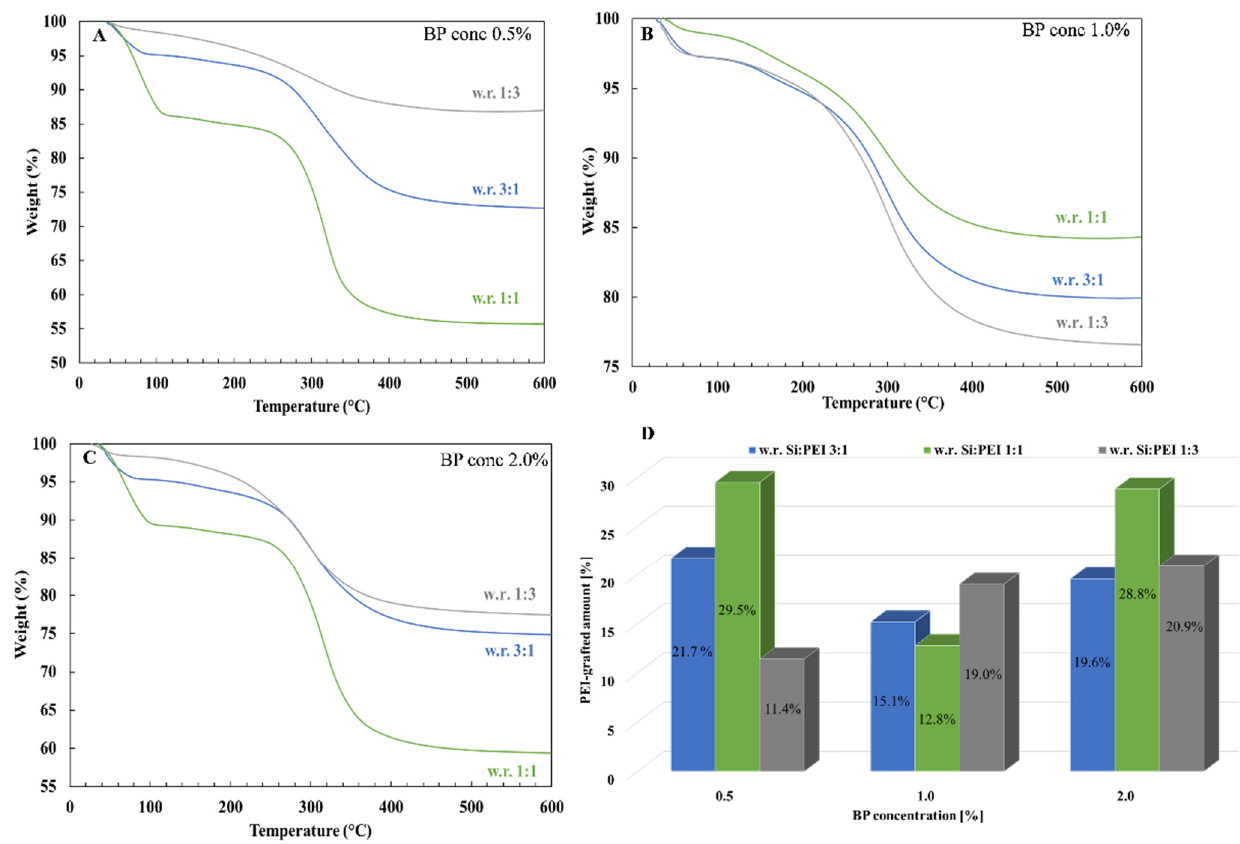
Figure 6. TGA thermograms of the samples PEI25/Y/Z after extraction with a weight ratio 1:3 (gray line), 3:1 (blue line) and 1:1 (green line) for a ( A ) 0.5%, ( B ) 1.0% and ( C ) 2.0% BP concentration and ( D ) histogram of grafted-PEI fractions.